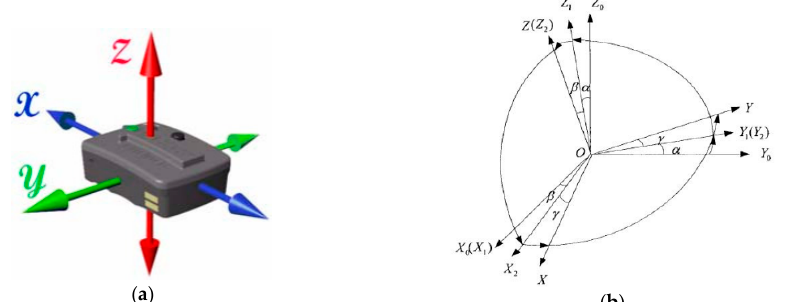
Figure 4. Schematic diagram of coordinate transformation. ( a ) Carrier coordinate system and ( b ) transformation of coordinate system.